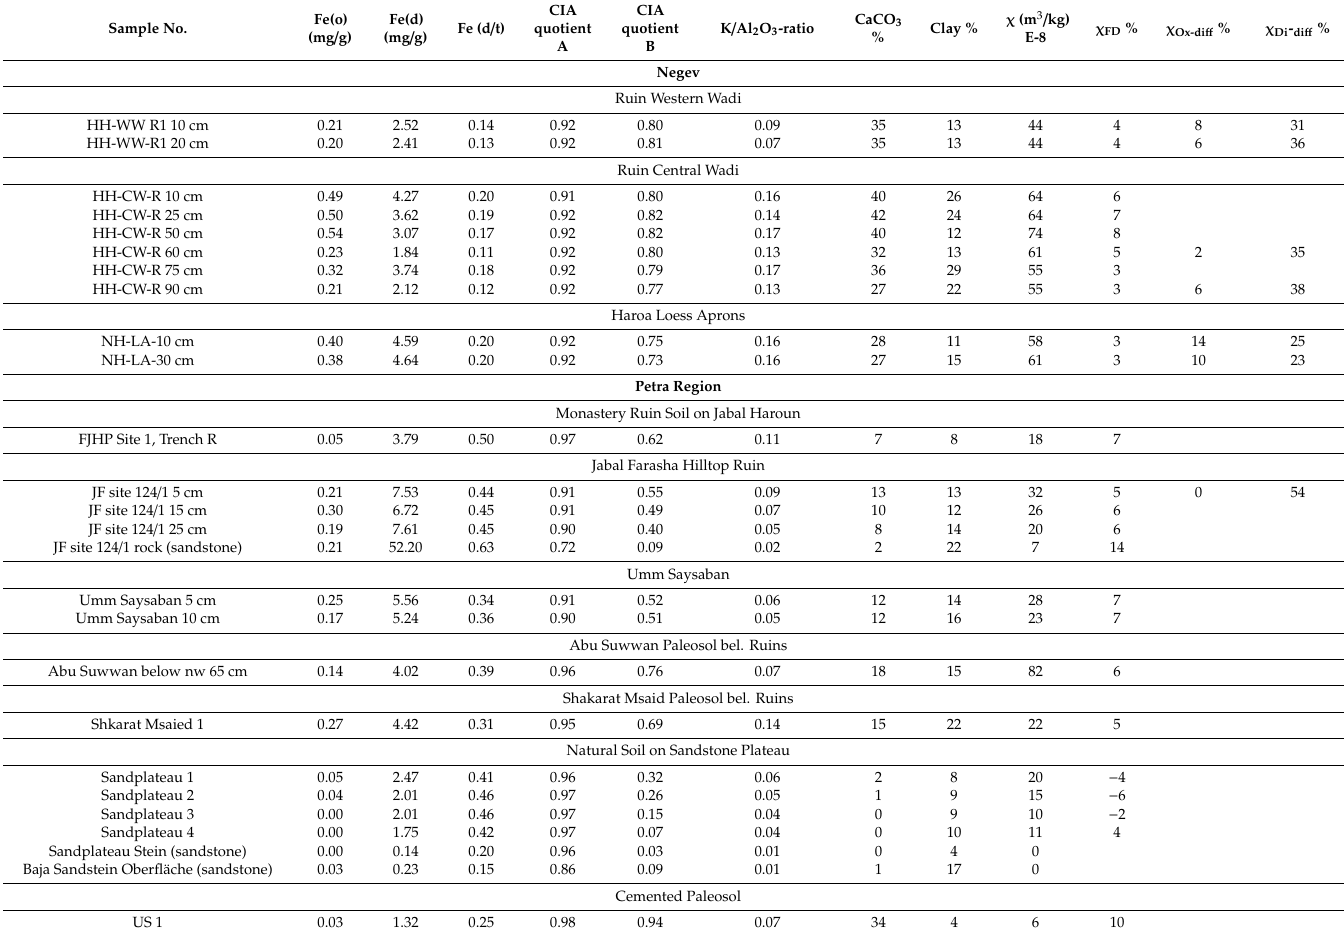
Table A5. Table summarizing indicators of pedogenesis in the studied hilltop soils. CIA refers to the index of chemical alteration according to [74]. χ is the weight-specific magnetic susceptibility, χ FD is the frequency-dependent change of susceptibility, χ Ox-di ff is the change of susceptibility after oxalate extraction, and χ Di-di ff after iron extraction with